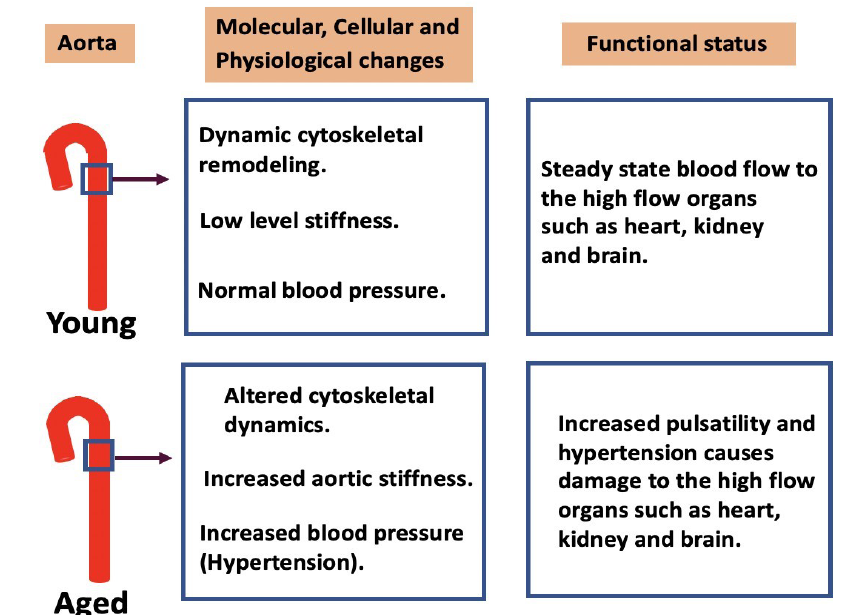
Figure 2. Cytoskeletal dynamics in the aorta with ageing and functional consequences. In young aortas dynamic cytoskeletal remodeling maintains low levels of stiffness and normal blood pressure which allow normal blood flow to the high flow organs such as heart, kidney, and brain. With advancing age, a decrease in cytoskeletal dynamics increases the stiffness of the aortic wall. This causes an increased pulsatility of the blood flow leading to damage of the end organs. Therapeutic interventions are required to prevent age-related adverse cardiovascular effects associated with vascular stiffness. Peptides that reduce stiffness by blocking cytoskeletal interactions or other novel approaches are of interest as future potential